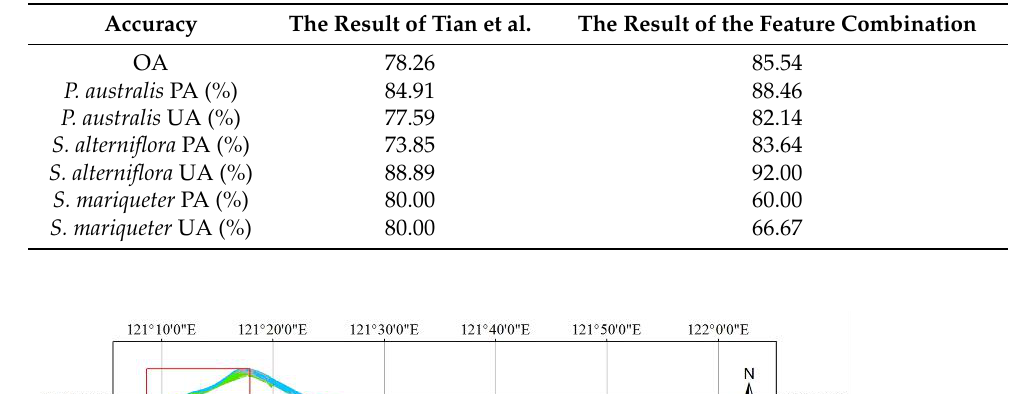
Table 7. Comparison of wetland vegetation extraction by the feature combination method considering phenology and Tian et al.’s method based on pixel phenological composition.